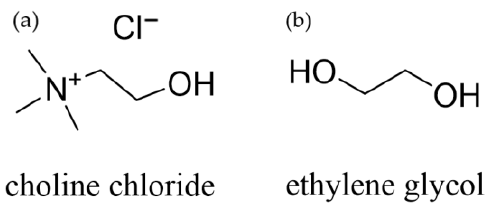
Figure 1. Chemical structures of ethaline components, ( a ) choline chloride (ChCl); ( b ) ethylene glycol (EG). Table 1. Compositions of ethaline-water mixtures investigated in the present work.